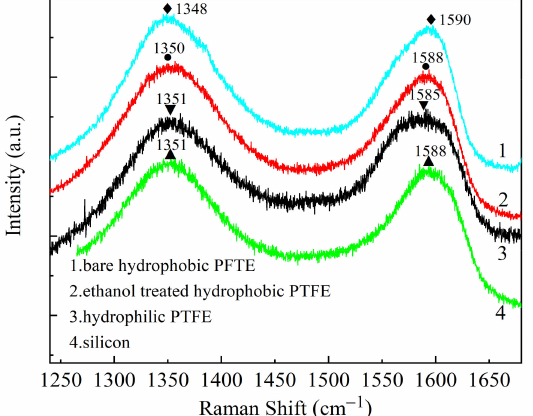
Figure 6. Raman spectrums of GO on different substrates: 1 . bare hydrophobic PTFE; 2 . ethanol- treated hydrophobic PTFE; 3 . hydrophilic PTFE; 4 .